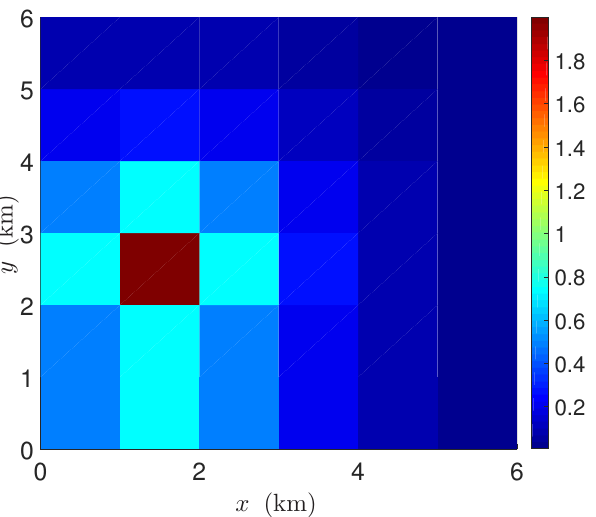
= [ 1.5,1.5 ] T , s 1 = 2, d 1 = 1. 1